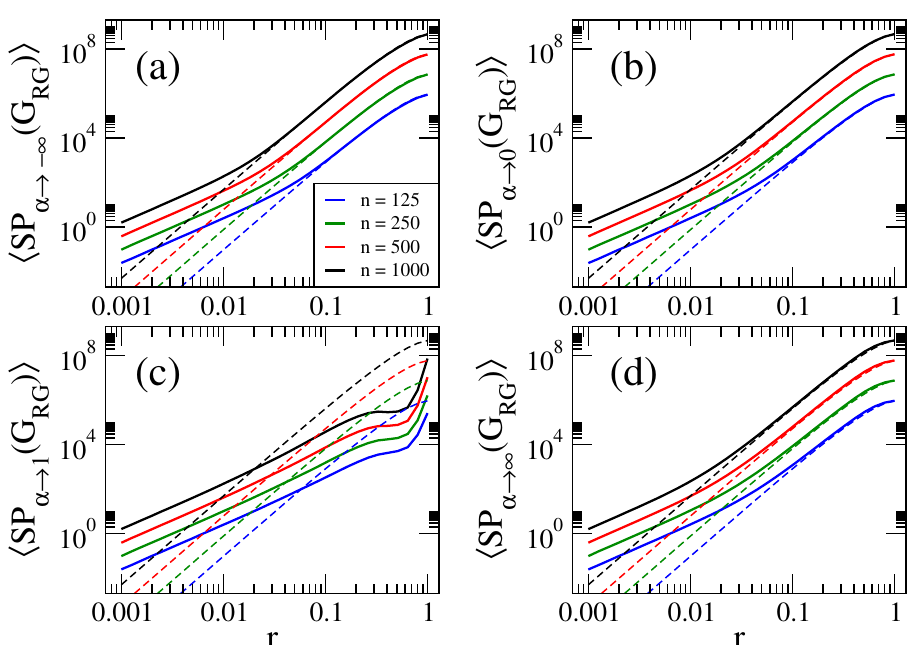
Figure 3: Average value of the Stolarsky–Puebla index (cid:104) SP geometric graphs of size n . Here (a) α → −∞ , (b) α → 0 , (c) α → 1 , and (d) α → ∞ . Dashed lines correspond to (14).